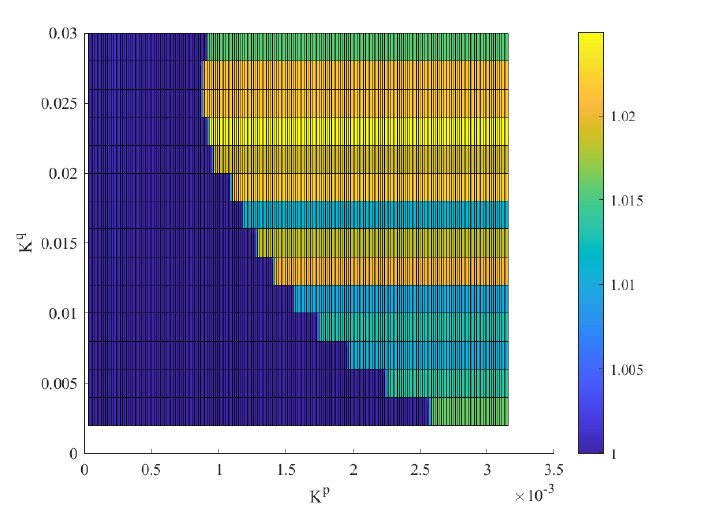
Figure 7. Stability boundary map with K p and K q as bifurcation variables (Dark blue stable, otherwise unstable).